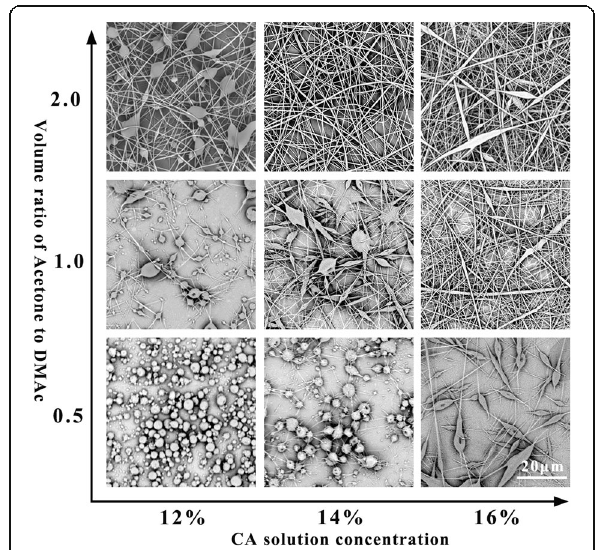
Fig. 2 SEM images of CA single electrospinning experiments of x - axis: CA solution concentration, of y -axis: volume ratio of DMAc to acetone. The applied voltage is 15 kV, the working distance is 10 cm, and the flow rate is 0.15